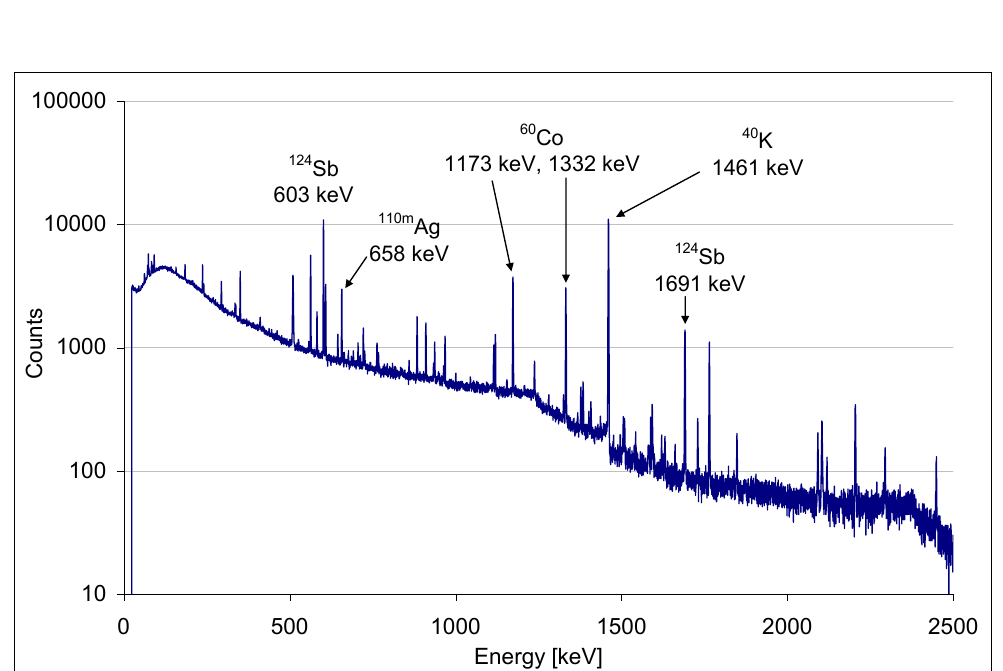
Figure 3. Gamma spectra of irradiated Cu target